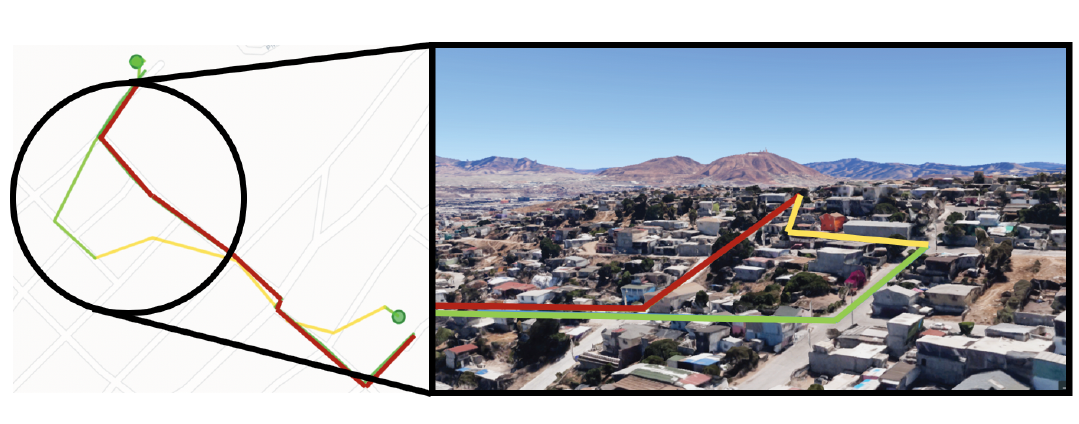
Figure 8. Differences between the expected route (red), as suggested by Google Maps, and the actual route (green-yellow) walked by the